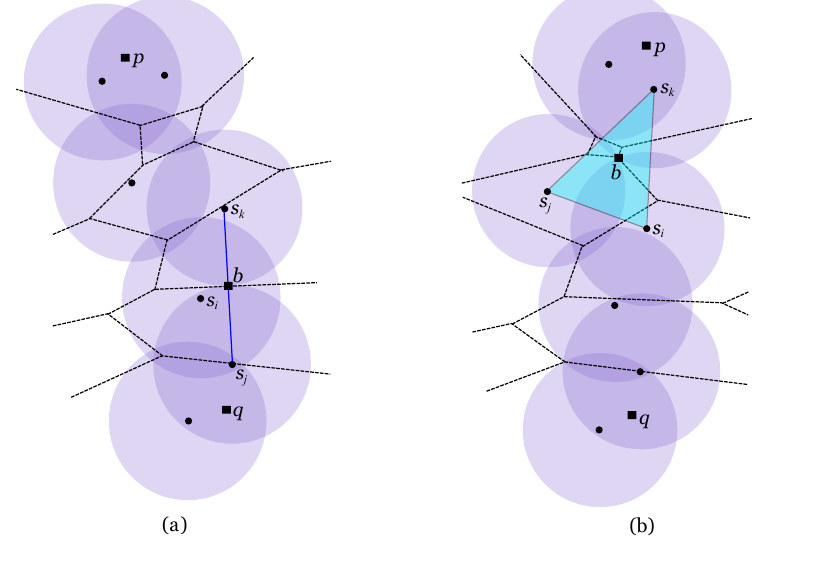
( S ) is shown in a dashed 2 ( p, q ) is a type II S